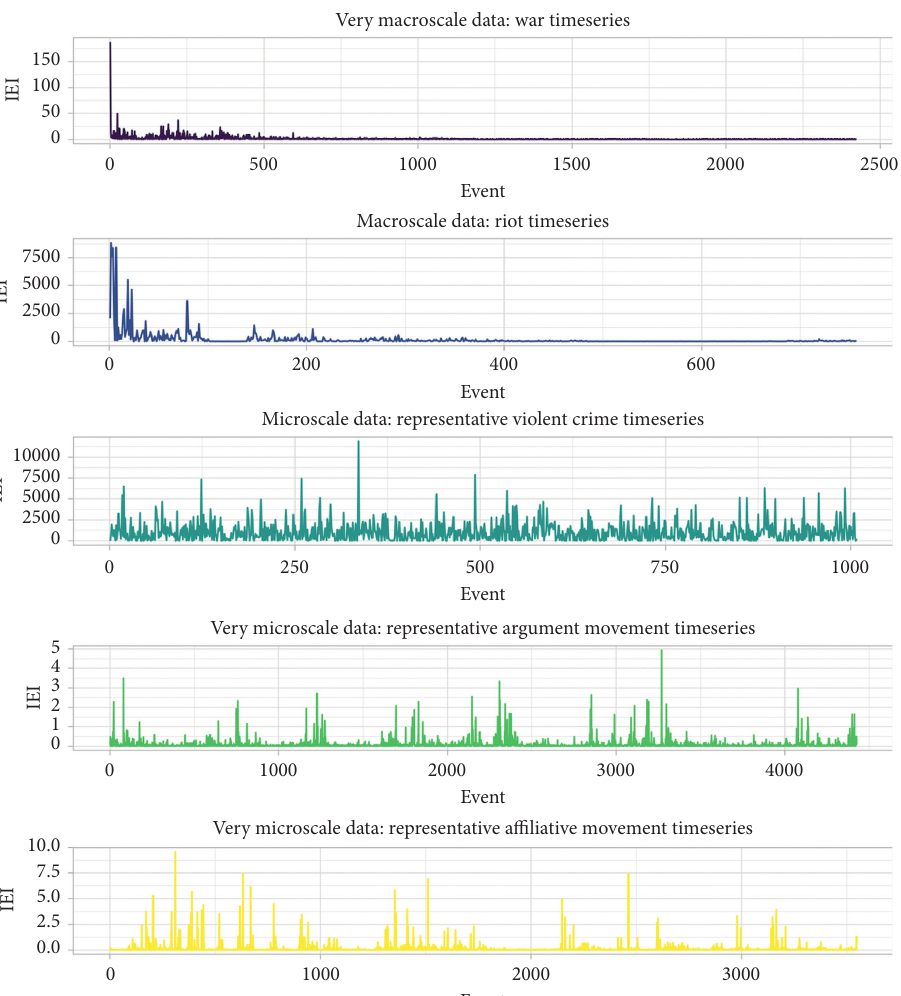
Figure 1: Complete time series for Wars and Riots, representative time series for Crime (Applewood, WI) and Argumentative/Affiliative Conversations. Crime and Conversation samples displayed are closest to the group mean